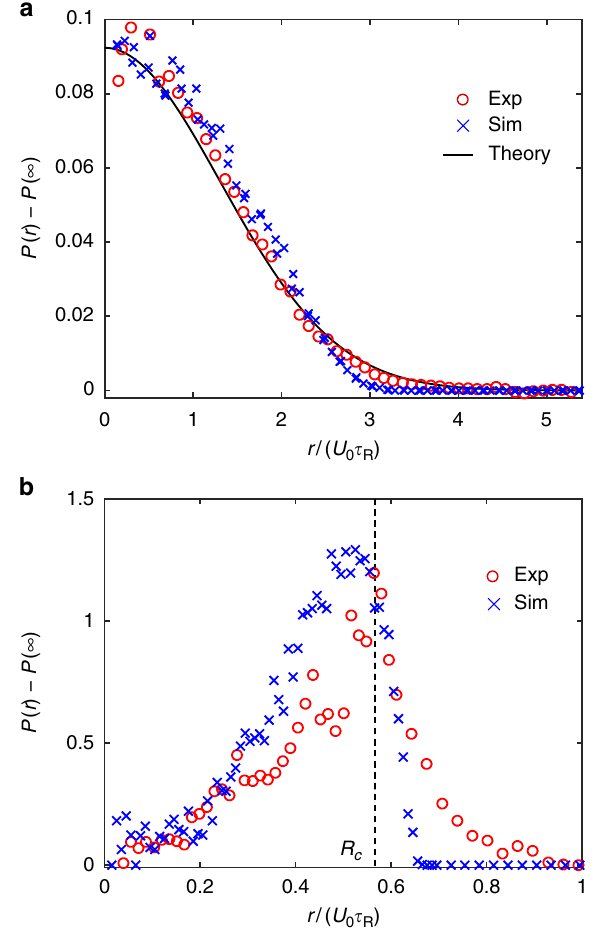
Figure 2 | Probability distribution of confined active Janus particles. ( a ) 2 m m swimmers with a (cid:5) k t R = z ¼ 0 : 29 follow a Boltzmann distribution (solid black curve is the analytical theory, equation 1). ( b ) Distribution of 3 m m swimmers with a ¼ 1.76 has a peak near R c ¼ z U 0 / k (vertical dashed black line) and decreases to zero for r 4 R c . In both a , b , the red and blue symbols are data from experiment and Brownian dynamics simulations, respectively. Data are averages of measurements of over 500 snapshots for a duration of 50s, each frame consisting E 100 and 20 particles for the a ¼ 0.29 and a ¼ 1.76 cases, respectively.